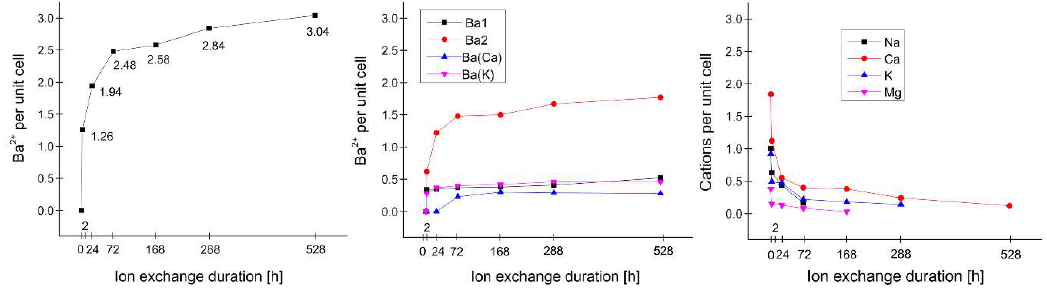
Figure 9. Extent of barium exchange (l eft ), barium sites ( middle ) and outgoing cations ( right ) at 90